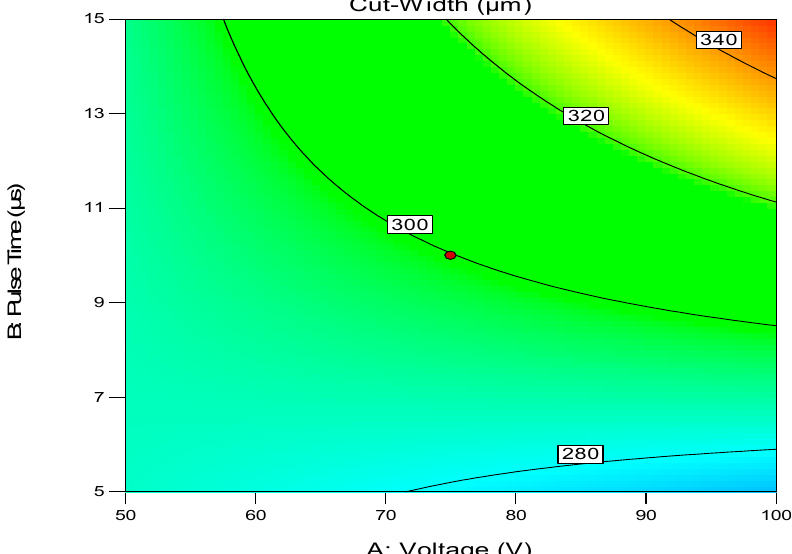
The regression equation analysis (9) shows the combination (interaction) of input process parameters (factors) affecting the value of the cut width. Figures 8 and 9 presents the response surface describing the dependence of the cut width on the voltage and pulse duration.